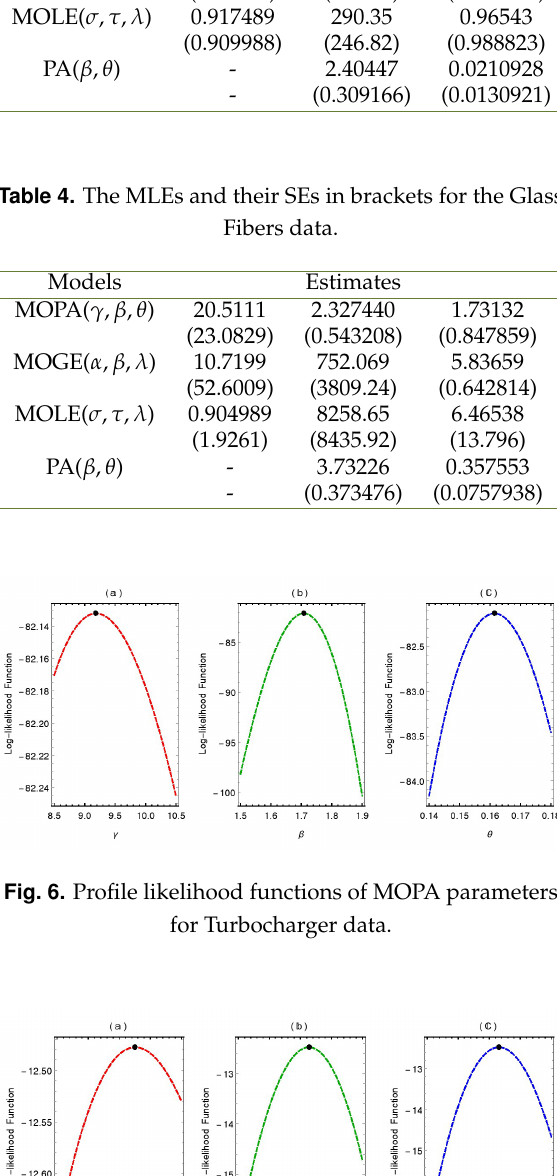
Table 7. The values of A ∗ , W ∗ , K-S and its p-value for the Turbocharger